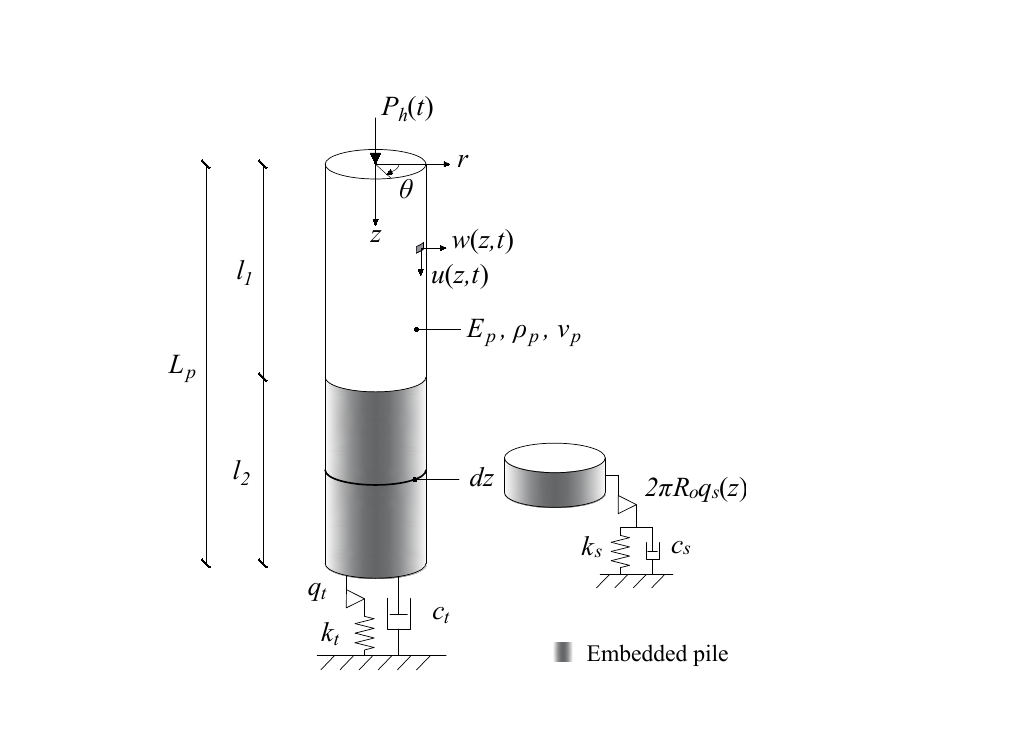
Figure 2. The three-dimensional axisymmetric pile driving model, with the pile described as a thin cylindrical